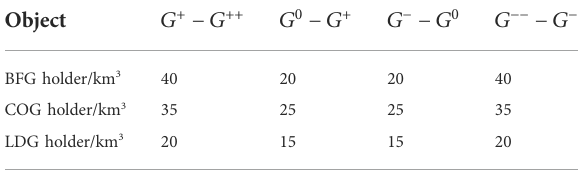
TABLE 2 Unit adjustment cost coef fi cient of the coal gas